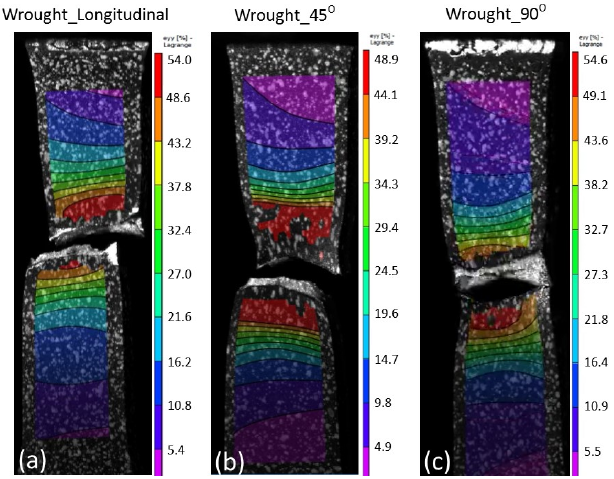
Figure 10. DIC images showing all samples at fracture states of wrought material. Note the maximum elongations at fracture locations were about ( a ) 54%, ( b ) 50% and ( c ) 54.5% on the 0 ◦ , 45 ◦ and 90 ◦ , respectively.